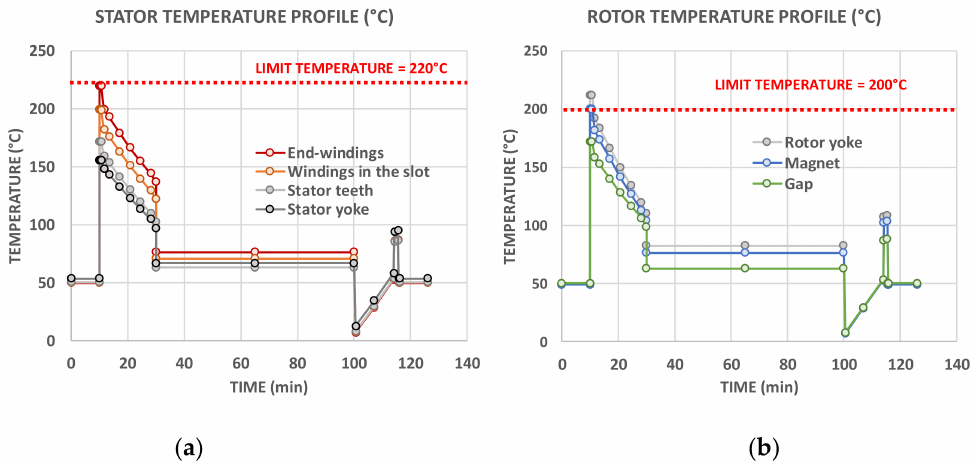
Figure 13. Temperature cycles for “steady-state thermal model”-based optimization: ( a ) stator side, and ( b ) rotor